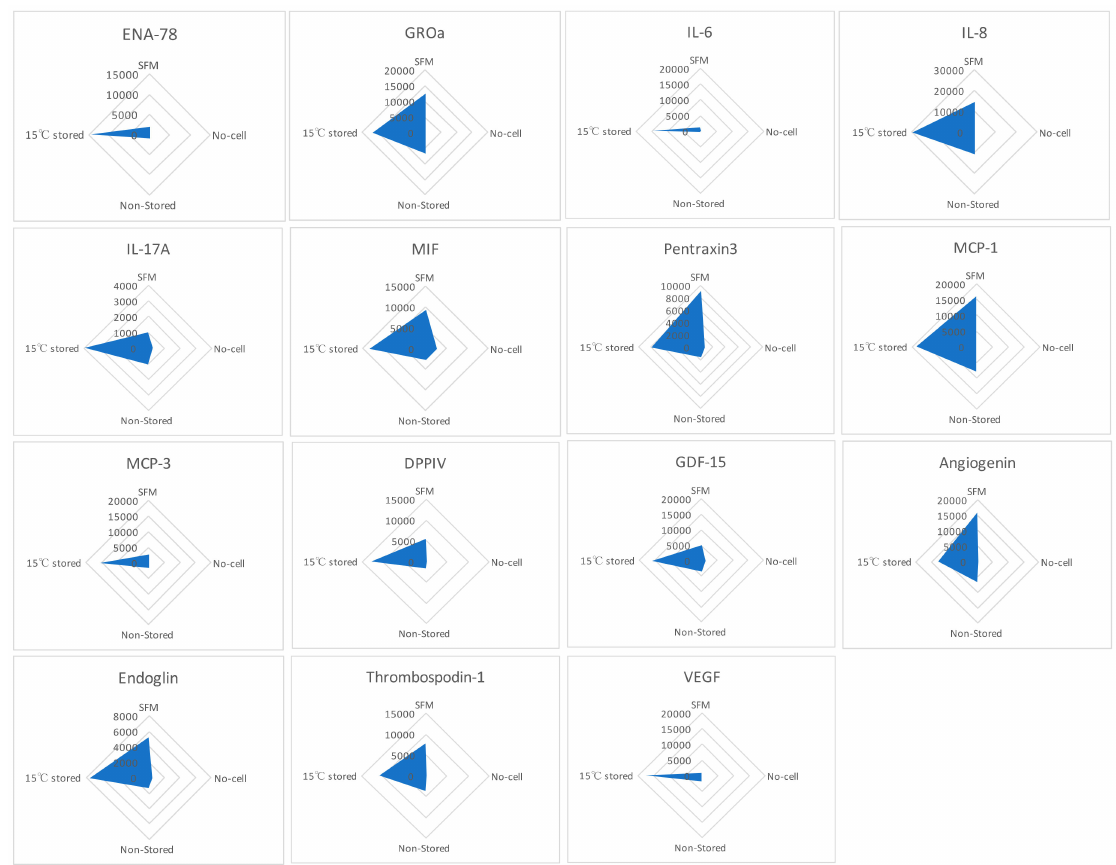
Figure 6. Cell production of paracrine factors. Human XL Cytokine Array kit was used to measure the relative expression of paracrine factors produced each condition. Graphs show the relative expression of epithelial-neutrophil-activating peptide (ENA-78), growth-regulated alpha protein (GROa), interleukin (IL-6, IL-8, IL-17A),microphagemigrationinhibitoryfactor(MIF),pentraxin3, monocytechemoattractant protein (MCP-1, MCP-3), dipeptidyl peptidase-4 (DPPIV), growth / di ff erentiation factor 15 (GDF15), angiogenin, endoglin, thrombospondin1, and vascular endothelial growth factor (VEGF). SFM, Serum-free media; no-cell bandages, alginate bandages formed without Ad-MSCs; non-stored bandage, bandages used immediately following formation; and 15 ◦ C-stored bandages, bandages used following 72 h storage. Values are presented from one biological donor and two technical